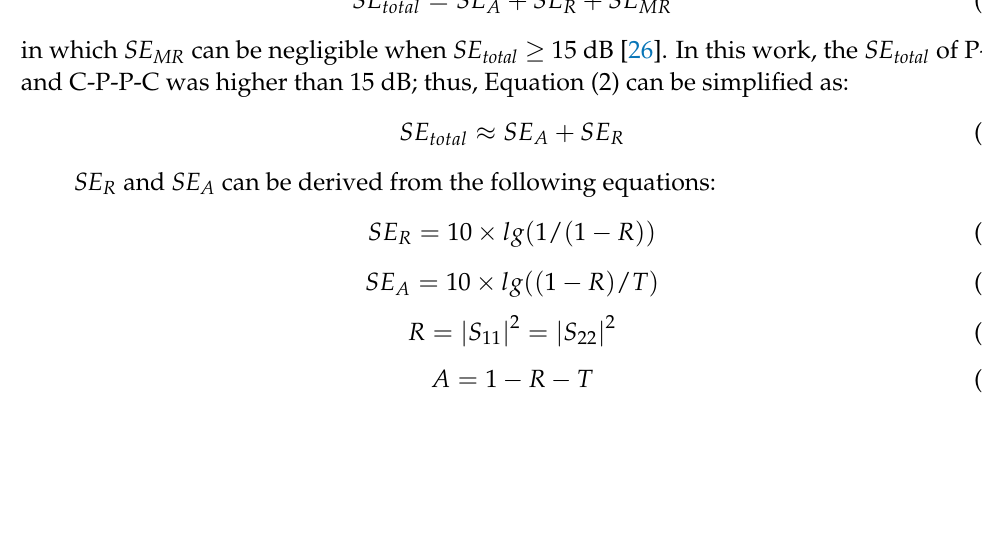
Figure 5. ( a ) EMI SE and electrical conductivities of P-P and C-P-P-C calculated using S 12 and S 21 ; ( b ) SE A , SE R and power coefficient of P-P and C-P-P-C calculated using S 11 and S 22 ; ( c ) schematic illustration of EMI shielding mechanisms of C-P-P-C. To assess the real applications of the composites, the ILSS, which is one of the crucial parameters for qualifying the mechanical properties of CFRCs, was tested. Figure 6a shows that the ILSSs of P-P and C-P-P-C were 88.3 and 87.0 MPa, respectively. The slight decrease might be attributed to the increase in porosity generated during the fabrication of C-P-P-C. The dominant failure mechanism of both P-P and C-P-P-C was interlaminar delamination, as shown in Figure 6b,c. These results indicated that the role of CNF sheets could be ignored in determining the mechanical properties of CFRCs.